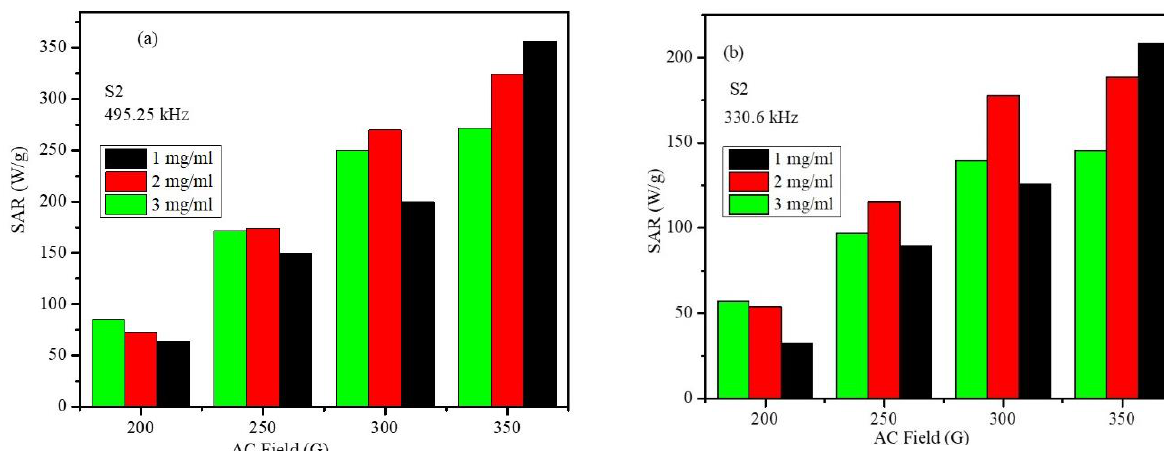
Figure 12. Concentration-dependent SAR values vs. the field at frequencies of ( a ) 495.10 kHz and ( b ) 330.6 kHz.